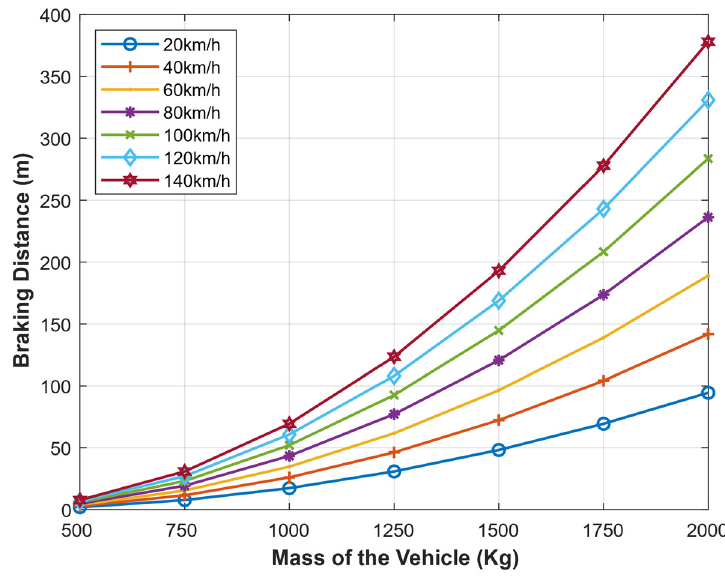
Figure 22. Braking Distance given the mass of a vehicle at different speeds.